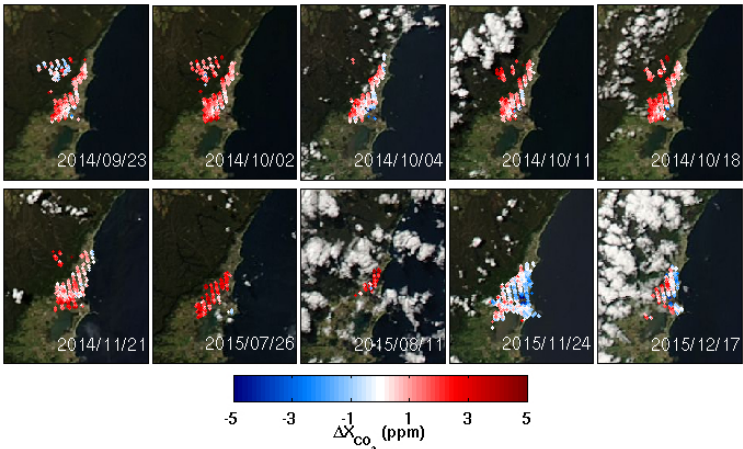
Figure 9. The filtered target-mode measurements over Wollongong. The colors represent the difference between the OCO-2 measurement and the coincident TCCON measurement. The OCO-2 data over Wollongong are generally higher (redder) than the TCCON measurements and significantly high in the July and August 2015 target-mode